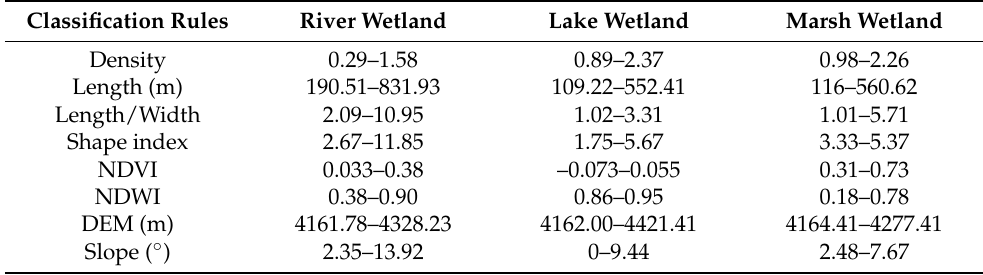
Table 4. Classification rule set of wetlands in the